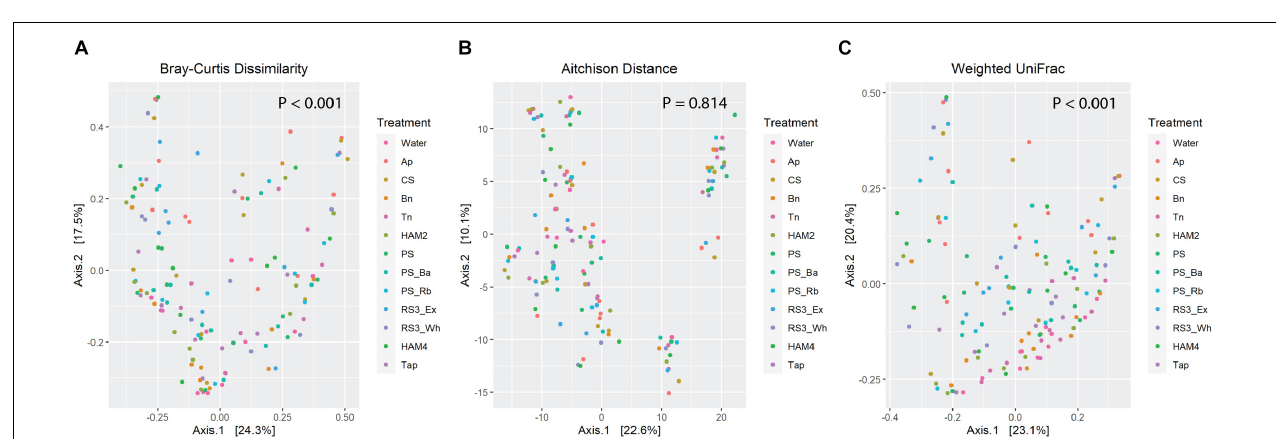
FIGURE 4 | Principle coordinate analysis plots of beta diversity metrics, with points colored by treatment. P -values are calculated by PERMANOVA via the Adonis function in the Vegan package in R. (A) Bray-Curtis dissimilarities derived from the DivNet package in R. (B) Aitchison distances calculated as the Euclidean distance between microbiomes following centered-log-ratio transformation of the count data, calculated via the Vegan and Microbiome R packages. (C) Weighted UniFrac distance calculated using the Phyloseq package in R on rarefied count